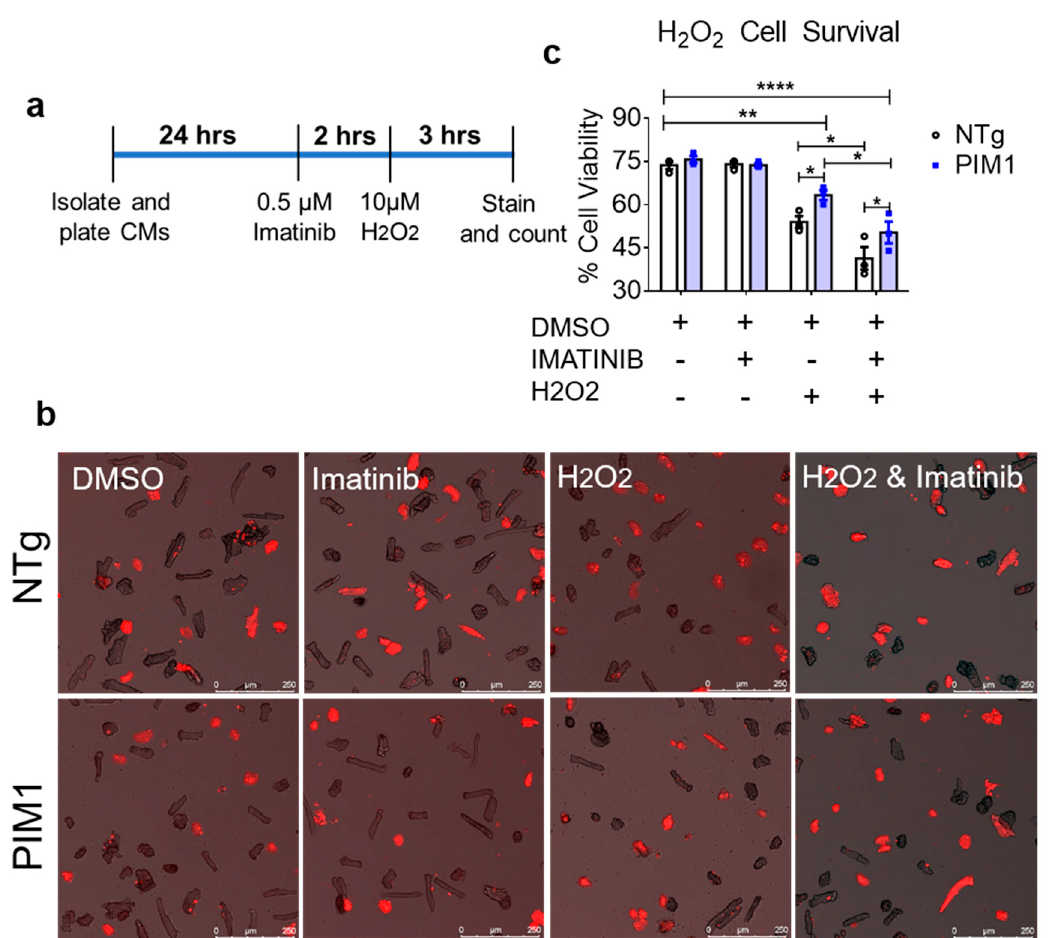
Figure 5. PIM1 and c-Kit act independently to confer cardioprotection. ( a ) schematic showing the treatment procedure. ( b ) Representative images of NTg and PIM1 cardiomyocytes stained with TO-PRO-3. Cells depicted in red are counted as non-viable cells. ( c ) Quantification of cell viability counted from fluorescent images. N = 5, 300–600 cardiomyocytes counted per group, error bars represent SEM, * p < 0.05, ** p < 0.01 and **** p < 0.0001 as measured by two-way ANOVA multiple comparison with Tukey.